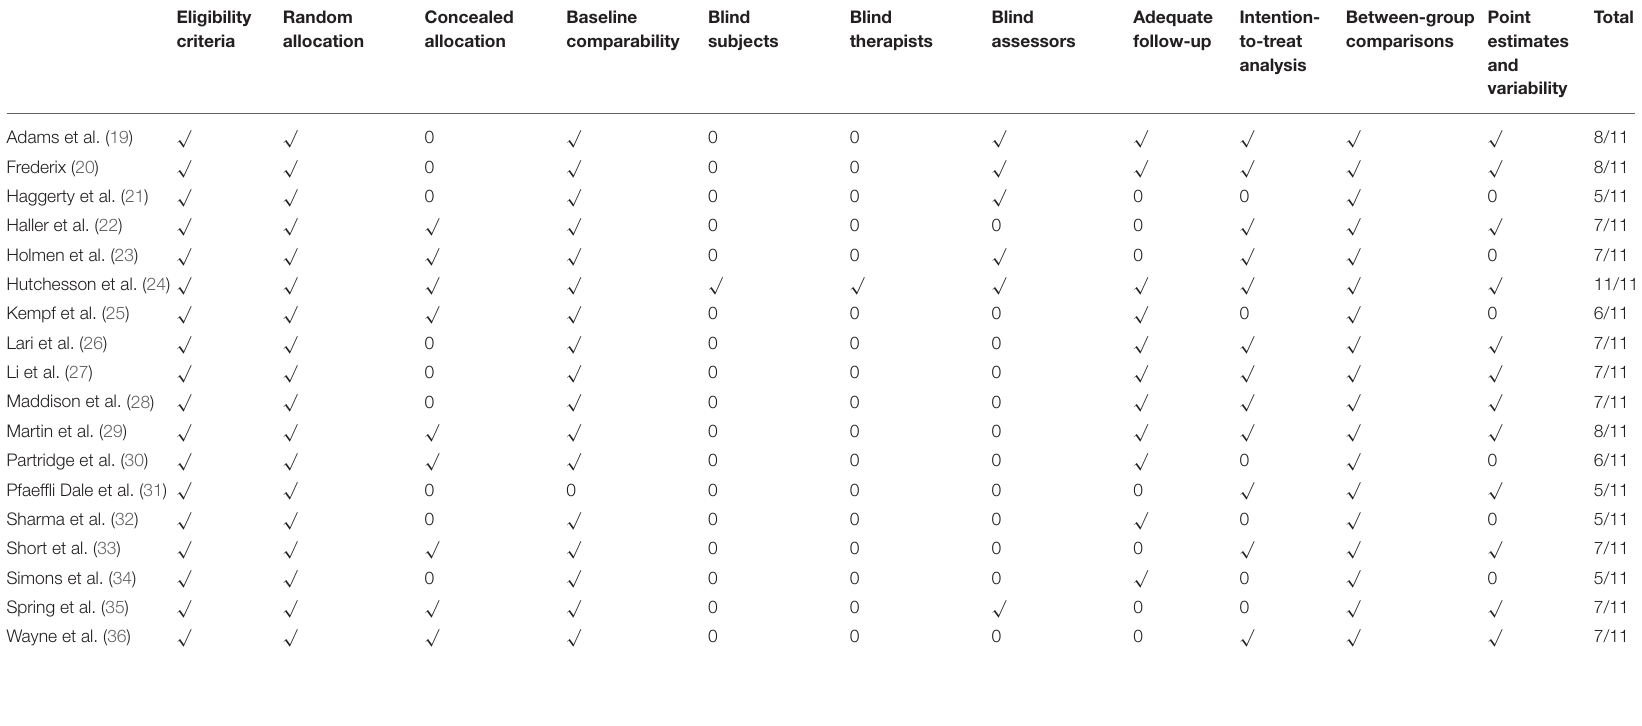
TABLE 1 | Validity of studies based on the PEDro